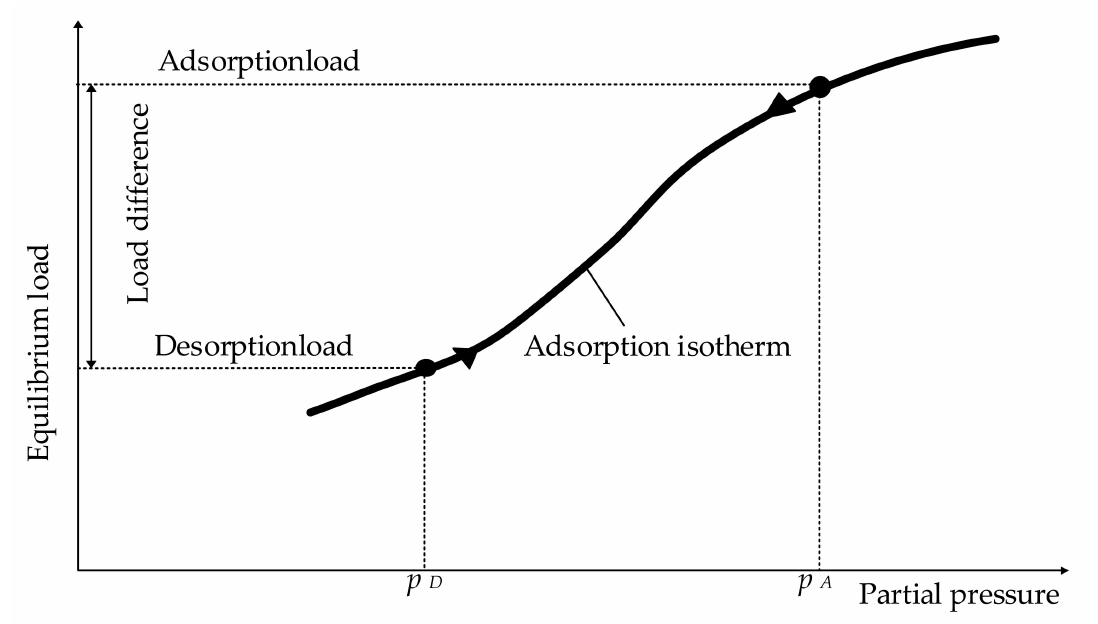
Figure 7. Adsorption and regeneration by pressure swing, emulated from [20] (p.